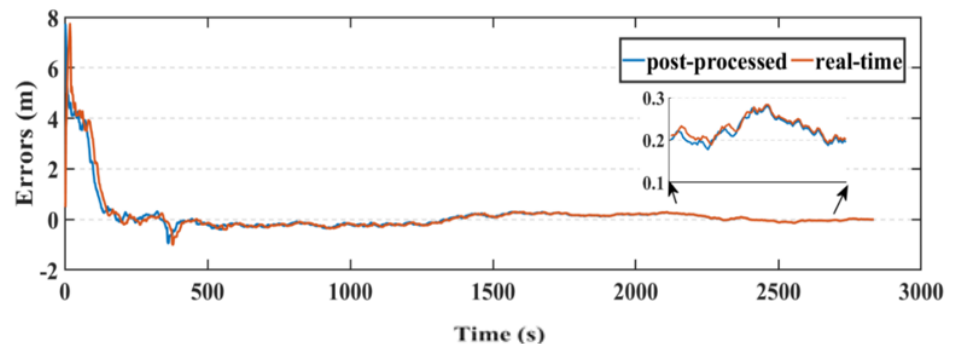
Figure 18. Position errors in North direction (first dataset).